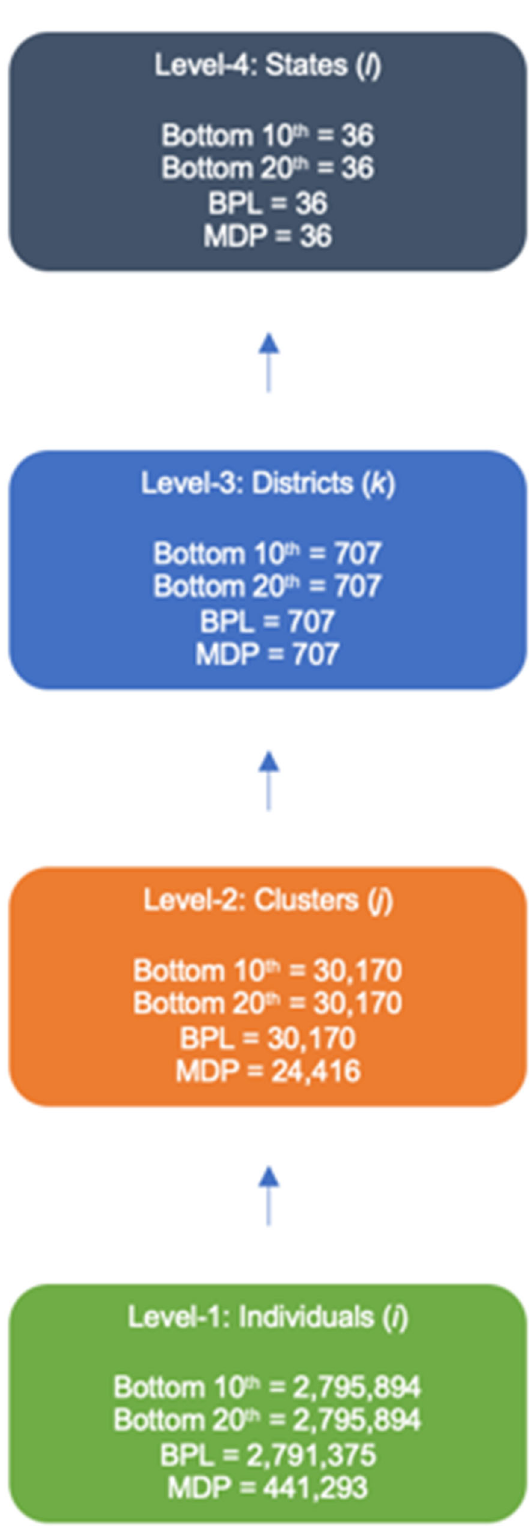
Fig. 1 Multilevel structure for four measures of poverty across states and Union Territories in India. Green describes individuals, orange describes clusters, blue describes districts, and gray describes